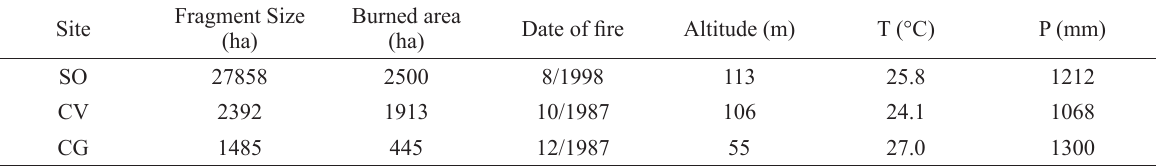
General information on the size of the studied forest fragments, size of area affected by the fire, date of fire, mean altitude, temperature (T) and mean annual precipitation (P) in the three forest fragments, Biological Reserve Sooretama (SO), Biological Reserve Córrego de Veado (CV) and Biological Reserve Córrego Grande (CGO), State of Espírito Santo,